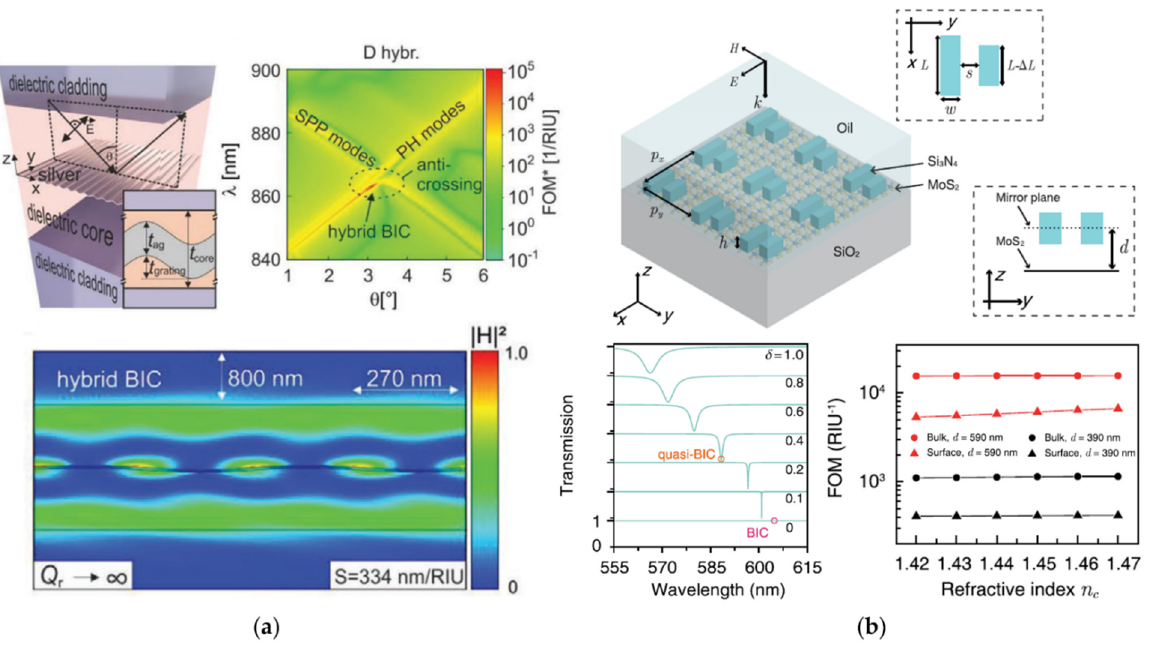
Figure 7. Hybrid metal-dielectric BIC biosensors. ( a ) A sine-modulated silver grating coupled with the dielectric material OrmoCore. Hybrid-BIC occurs at the “avoiding cross” of SPP modes and photonic (PH) modes, and has infinite radiation quality Q r (reprinted with permission from [101], ©2020, Wiley-VCH GmbH); ( b ) a symmetry-broken BICs metasurface composed of Si 3 N 4 symmetry-broken metasurface and MoS 2 monolayer with excellent sensing ability of maintaining high FOM under different RIs (reprinted with permission from [104], © 2022, IOP).